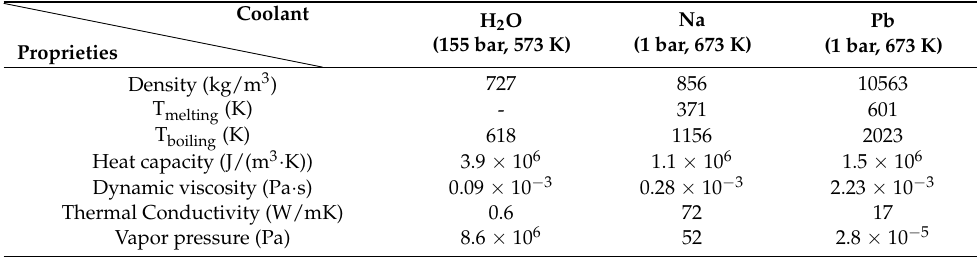
Table 1. Thermo-physical proprieties of water, sodium and lead: above the name of the coolant were reported the normal operating conditions in the nuclear coolant system use